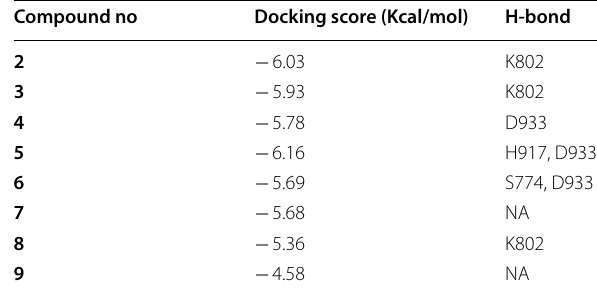
Table 5 The QPLD docking scores (Kcal/mol) and H-bond interactions between the verified compounds